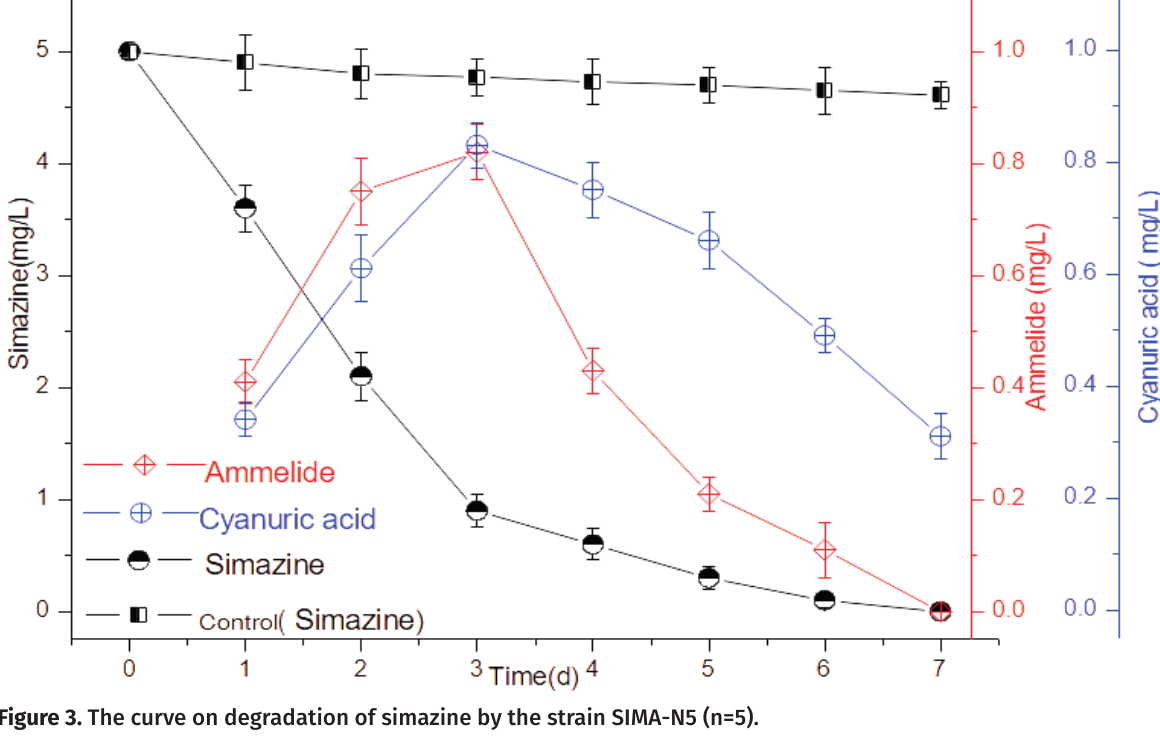
Figure 3. The curve on degradation of simazine by the strain SIMA-N5